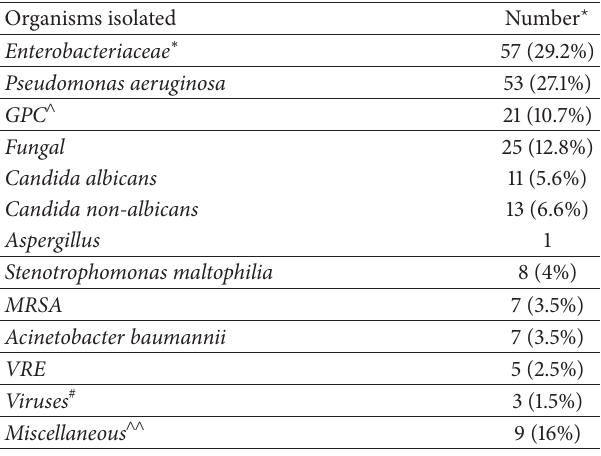
Table 1: Characteristics of patients. Table 2: Frequencies of all microbial